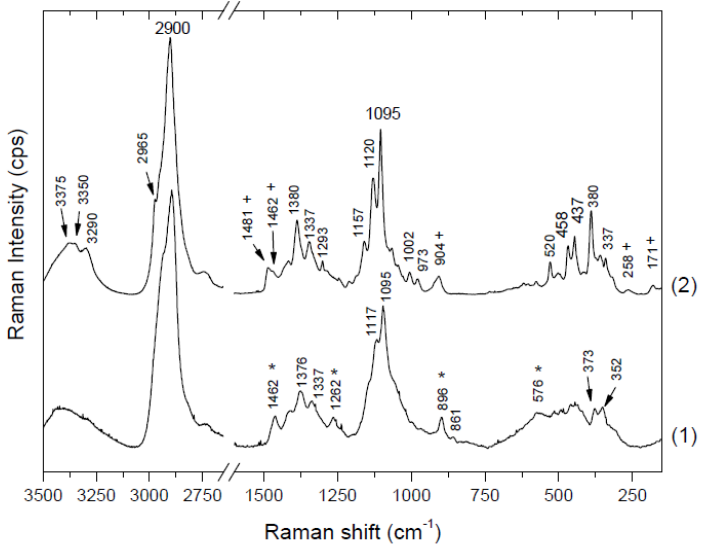
Figure 1. Raman spectra of apple (1) and microcrystalline (2) cellulose in the range 3,500–2600 and 1,600–150 cm −1 . There are marked peaks characteristic for amorphous (*) and crystalline (+) celluloses.